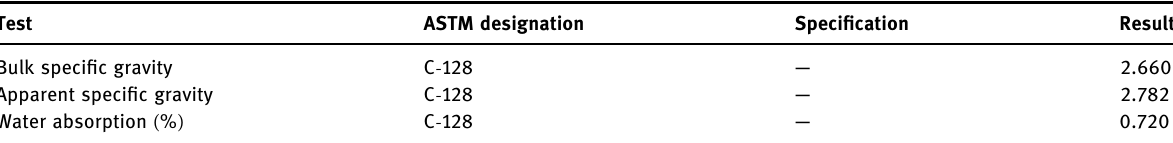
Table 3: Physical characteristics of fi ne aggregate river